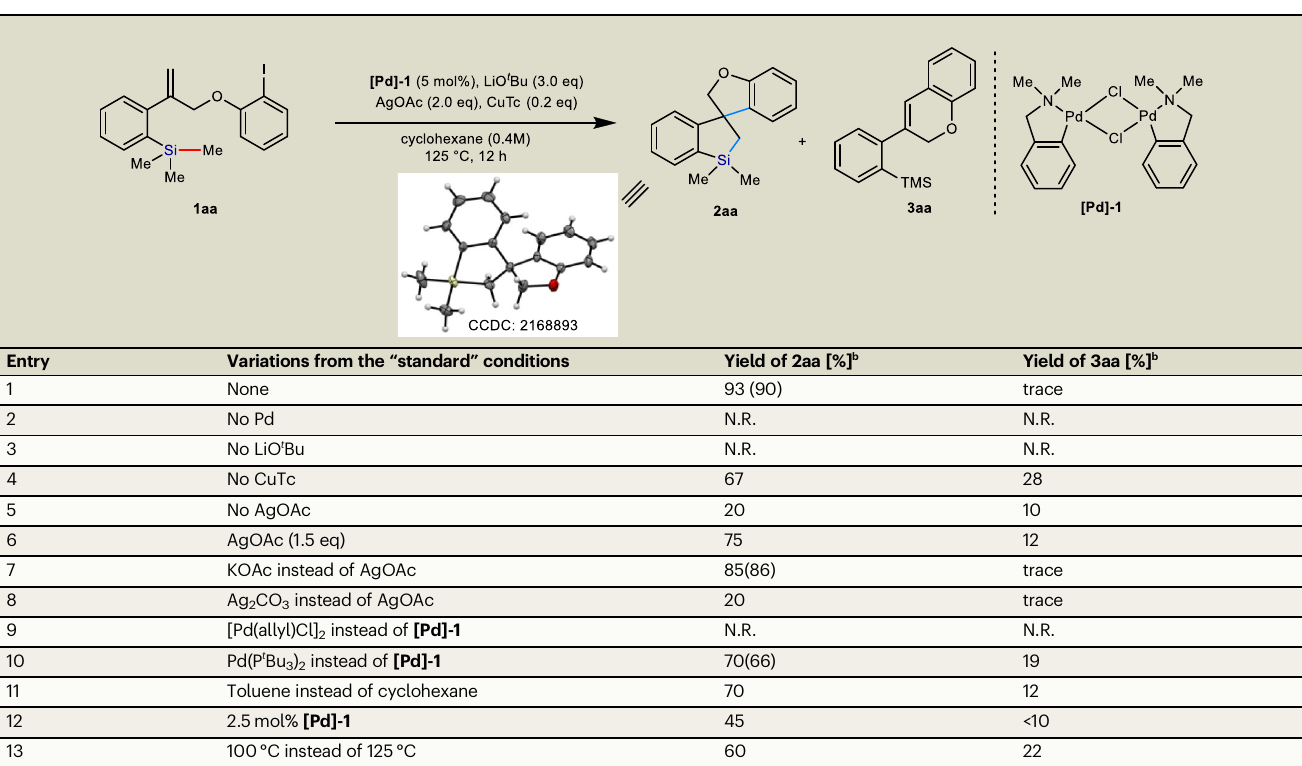
Table 1 | Condition optimization